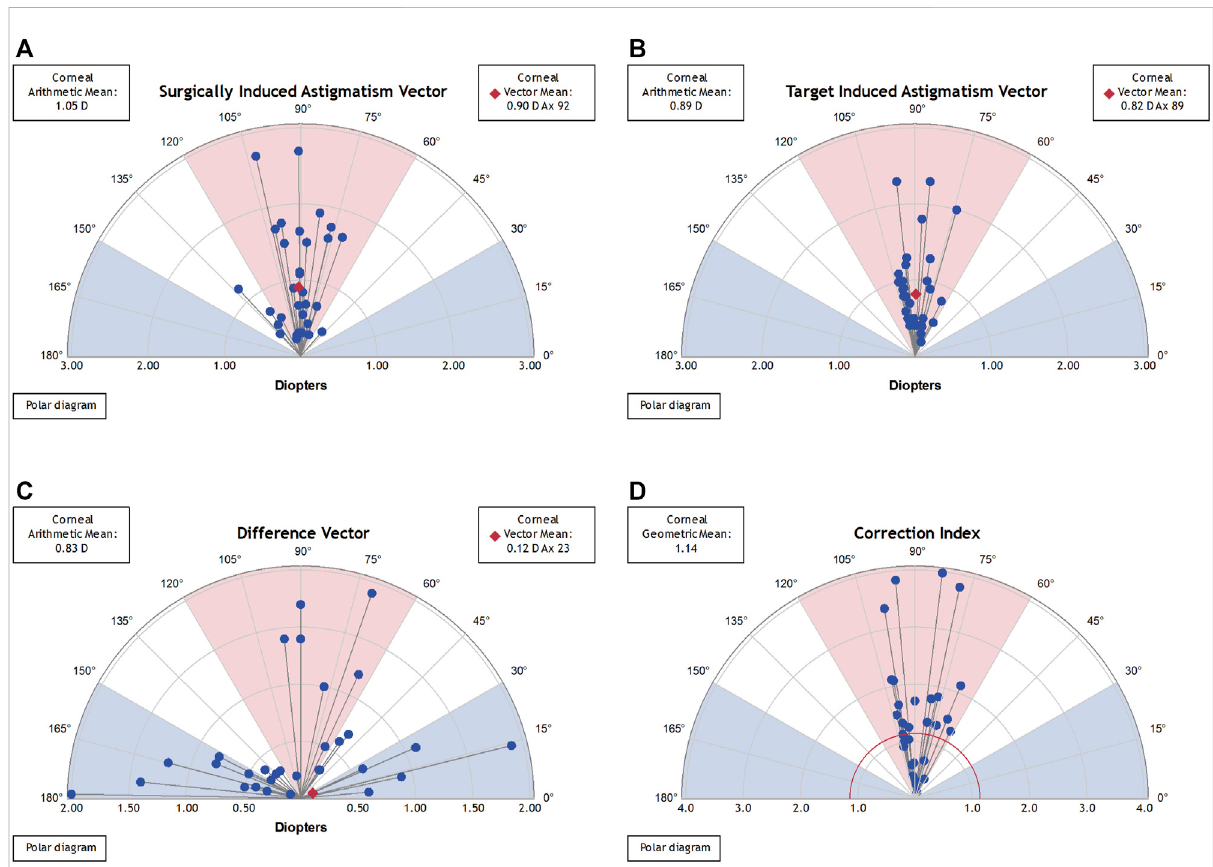
FIGURE 5 Single-angle polar plots for a single FSAK group. The vector average values were plotted in the form of a red diamond (estimated using the double-anglevectorspace)andtheSDvaluesforthe X and Y axeswerepresentedinacall-outbox. (A) .SIAvector; (B) .TIAvector; (C) .DV;and (D) .CI.